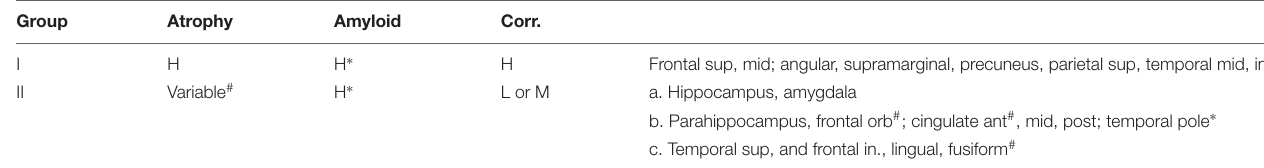
c. Temporal sup, and frontal in., lingual, fusiform